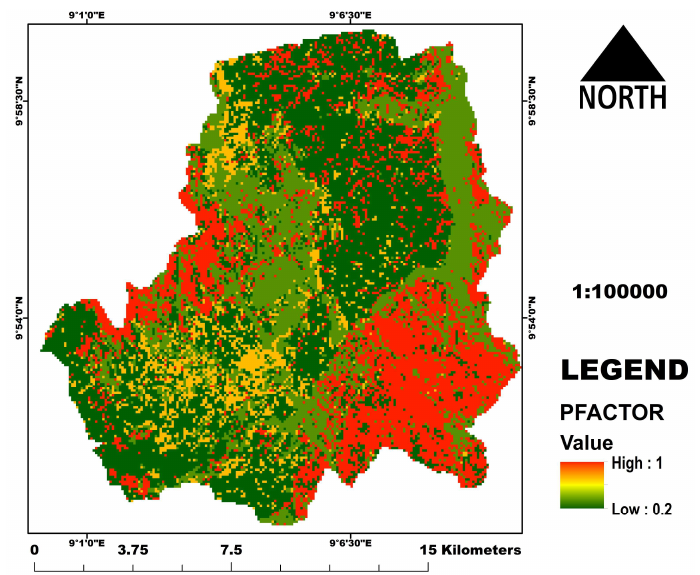
Figure 12. The P factor map.